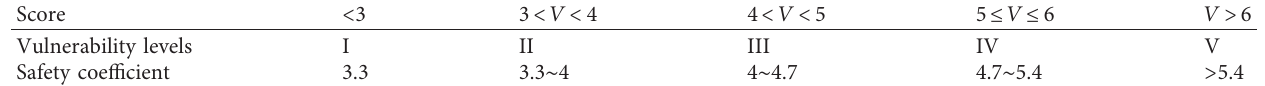
Table 21: Classification standard for vulnerability of surrounding rock and safety